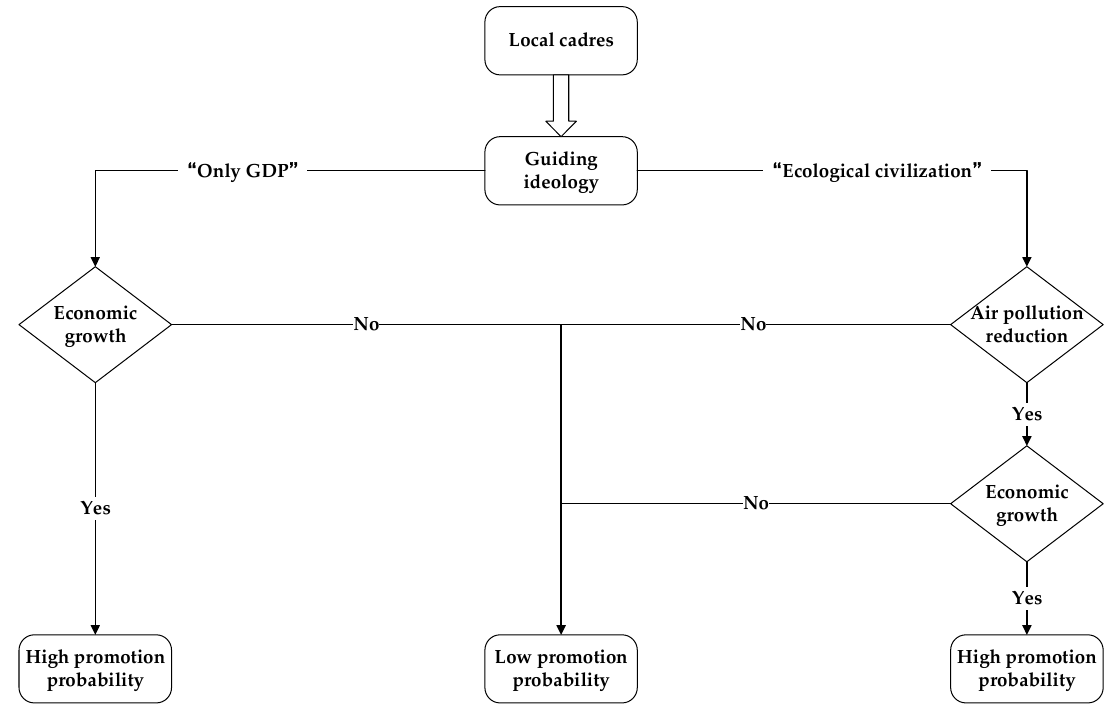
Figure 1. Two types of promotion logic in China.